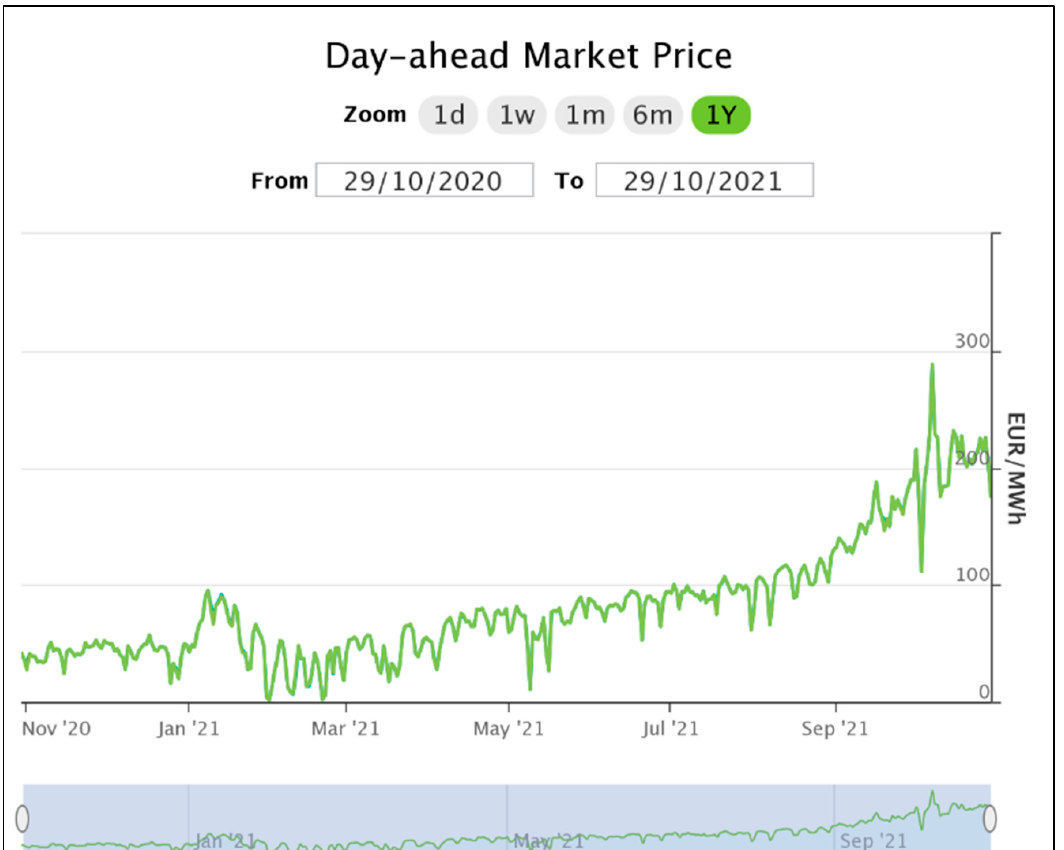
Figure 4. Electricity market price evolution for the period 2020–2021.